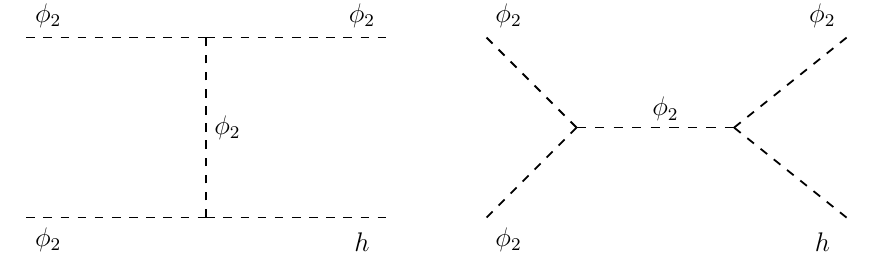
Table 3 . The 2 → 2 processes that are allowed in the Z 6 (23) model and that can modify the relic density of φ 1 (left) and φ 3 (right). h denotes the SM Higgs boson. Conjugate and inverse processes are not shown.